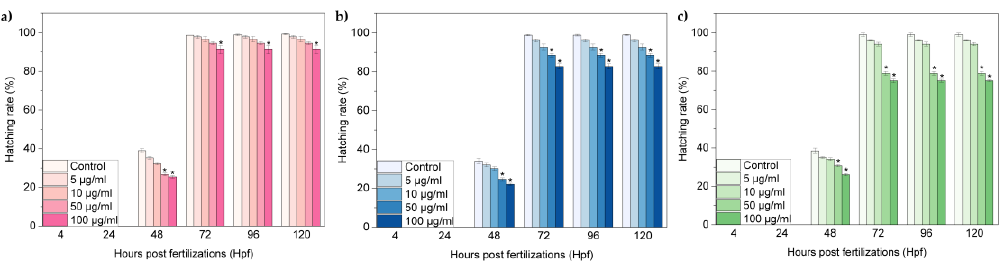
Figure 5. Hatching rates of zebrafish treated with ( a ) oxi-CNOs, ( b ) oxi-CNHs and ( c ) GO. Values are expressed as means ±S.D.